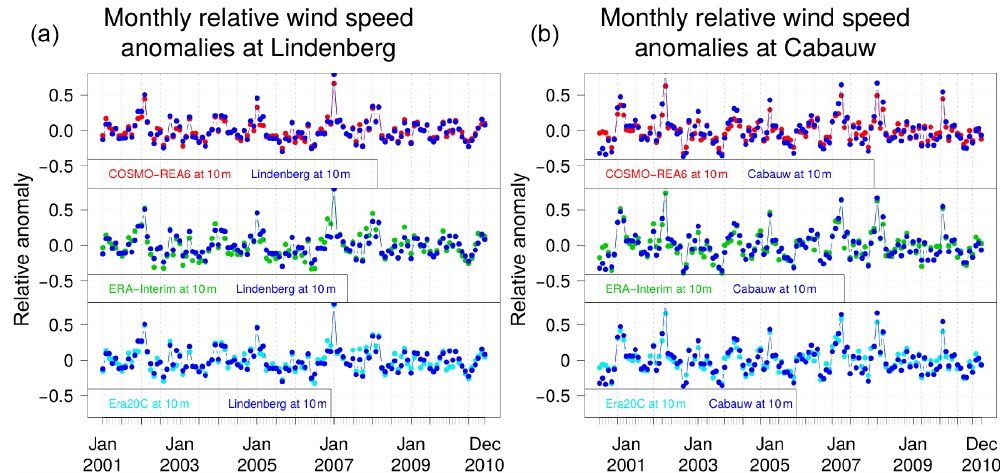
Figure 3. Time series of relative anomalies in monthly mean wind speed at Lindenberg (left) and Cabauw (right) mast measurements at 10m height against regional reanalysis (COSMO-REA6) and global reanalyses (ERA-Interim and ERA20C).